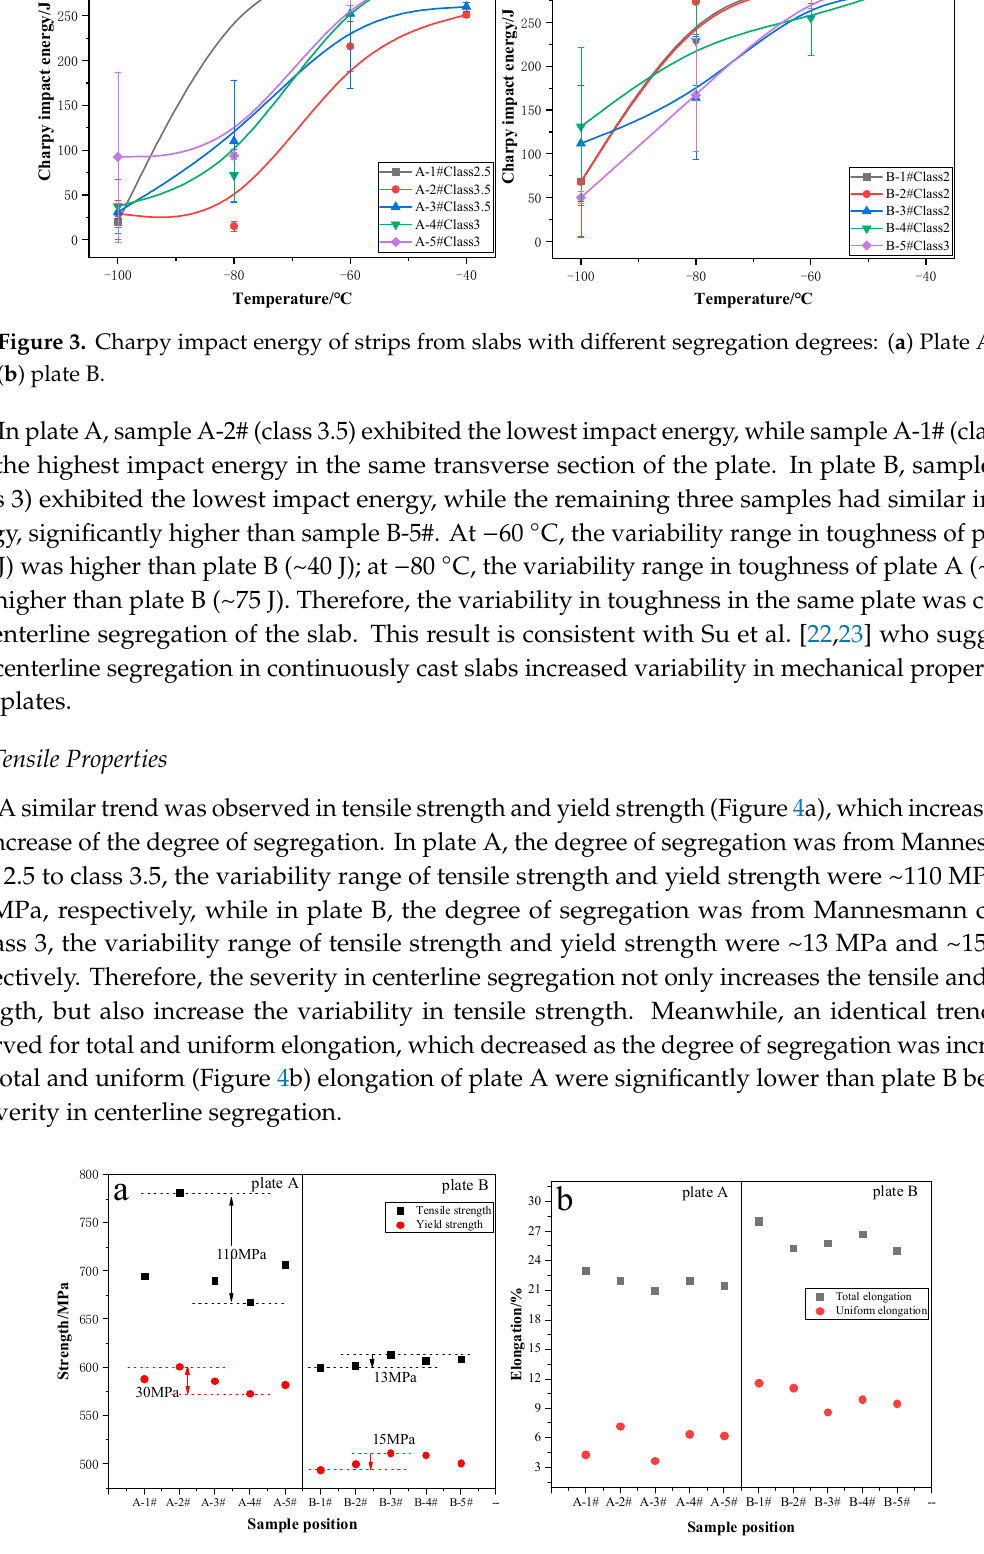
Figure 4. Tensile test result of plates from slabs with different segregation degree: ( a ) Tensile and yield strength, ( b ) total and uniform elongation.